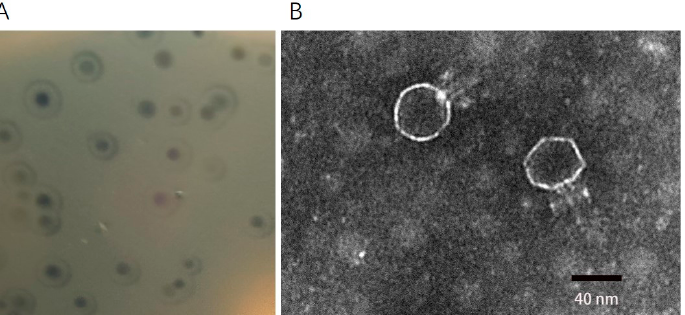
Figure 1. Morphology of phage DCp1. ( A ) Plaques produced by phage DCp1 on the lawn of C. perfringens . ( B ) TEM image of phage DCp1 with a regular icosahedral head (46 nm in diameter) and a short tail (40 nm in length).